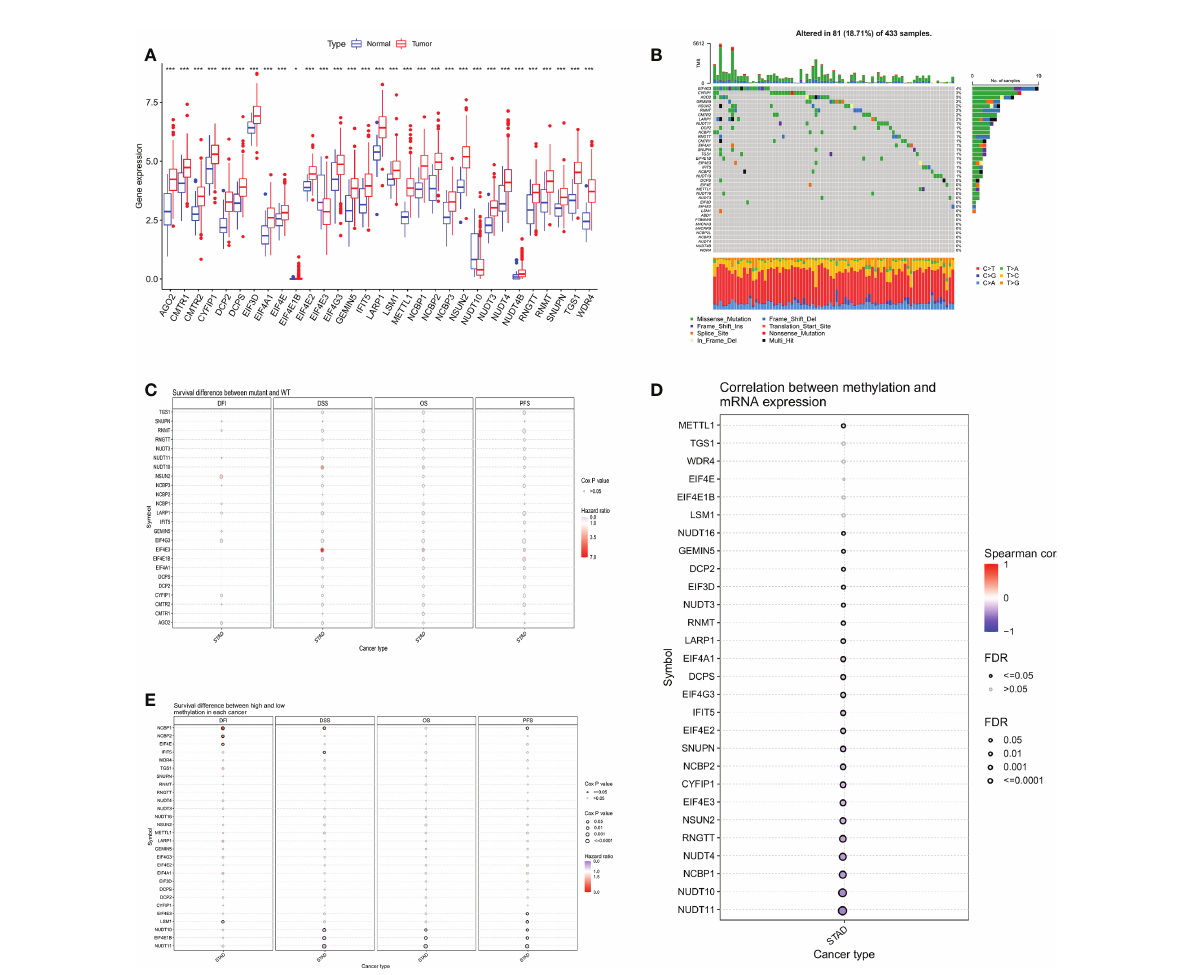
FIGURE 2 (A) Differential expression analysis of 31 m7GRGs in GC and normal tissues. (B) Mutation frequency of m7GRGs in GC patients in the TCGA- STAD cohort. (C) Relationship between mutations in m7GRGs and patient prognosis. Association of methylation levels of m7GRGs with gene expression (D) and patient prognosis (E) . m7GRGs, m7G-related genes; GC, Gastric cancer; STAD, Stomach adenocarcinoma; TCGA, The Cancer Genome Atlas. *P < 0.05 and ***P <